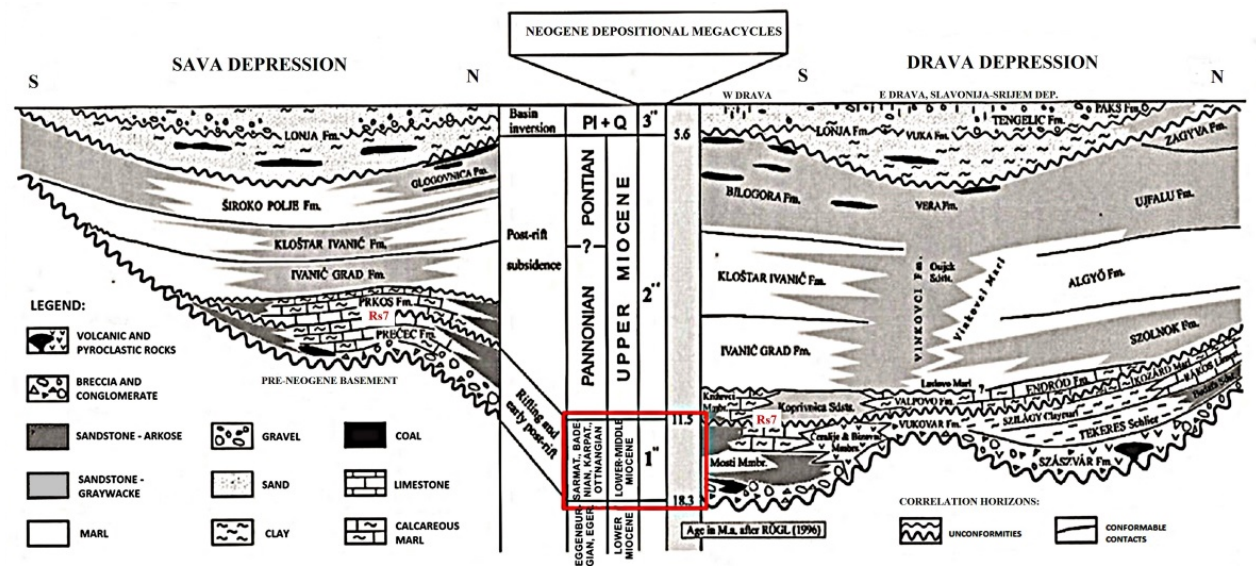
Figure 6. Subsurface lithostratigraphic units in the Sava and the Drava Depressions, grouped in the three Neogene megacycles. Middle Miocene deposits belong to upper part of the 1st megacycle, marked by a red rectangle (modified after [10]). A boundary between the Paratethyan marine and the Pannonian Lake lacustrine deposits can be well recognized from well-logs and is known as the Rs7 marker. Position of depressions shown in Figure 5.